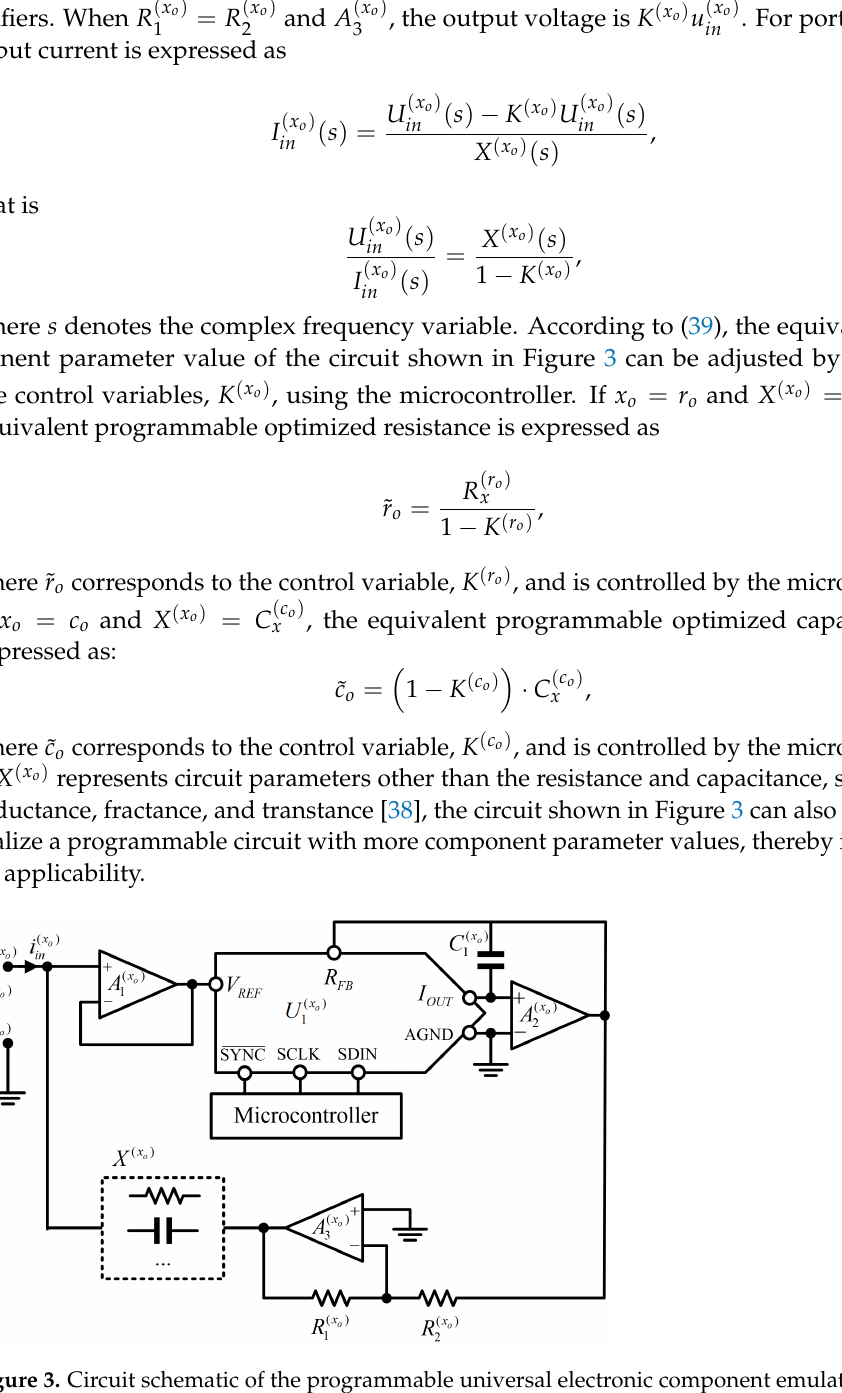
Figure 3. Circuit schematic of the programmable universal electronic component